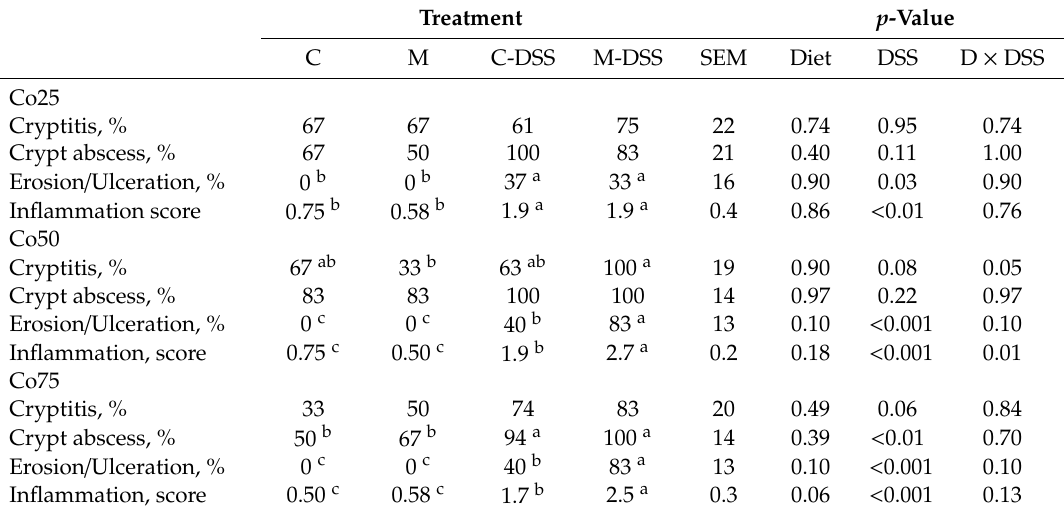
Table 3. Histopathological parameters measured as percentage of pigs with cryptitis, crypt abscesses, erosion / ulceration and the overall inflammation score in the proximal (Co25), mid (Co50) or distal (Co75) colon after five days of DSS or placebo treatment in pigs fed the control (C) or the meat (M) diet ( n = 6 / group, except C-DSS n = 5). Least square mean values with their standard errors. Treatment p